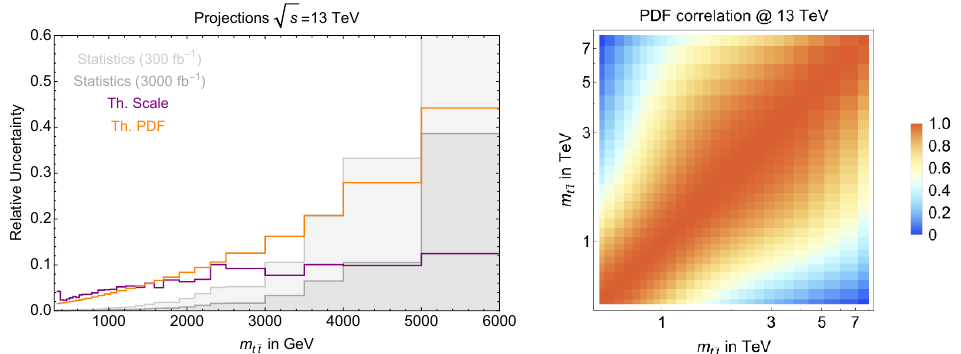
Figure 2 . Projected theory and statistical uncertainties (1 (cid:27) ) for the t (cid:22) t invariant mass distribution at the 13 TeV LHC. Statistical uncertainties are evaluated for the two di(cid:11)erent integrated luminosi- ties of 0.3 and 3 ab (cid:0) 1 . The left panel shows the size of the uncertainty in each invariant mass bin, and the right panel shows the correlation of the PDF uncertainty across di(cid:11)erent invariant